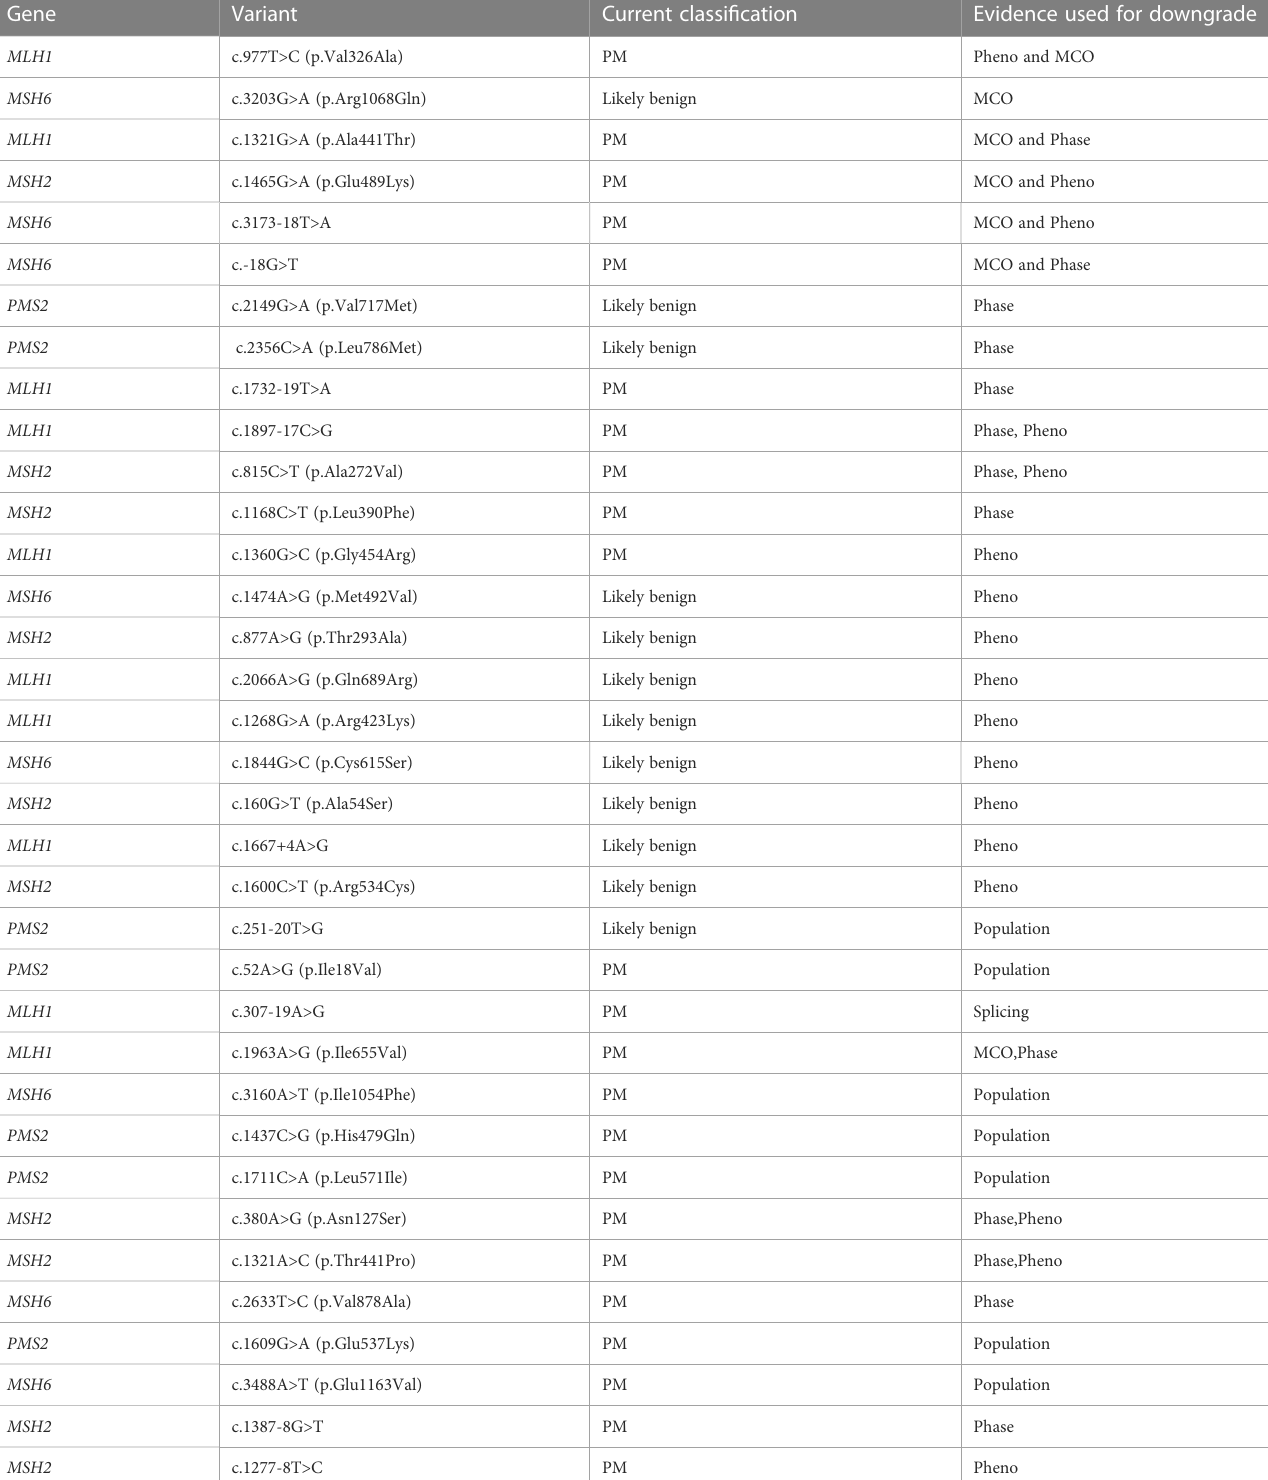
TABLE 7 35 variants downgraded from VUS to Benign/Likely